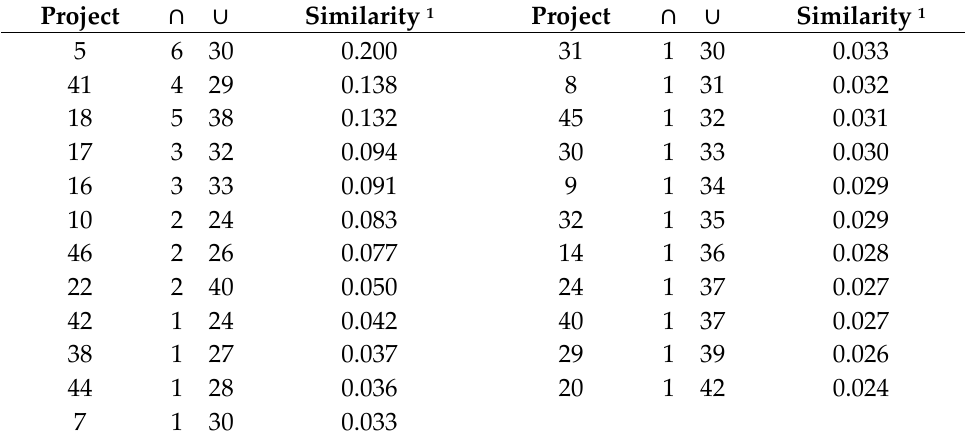
Table 4. Projects relevant to a given subset of tokens (S i